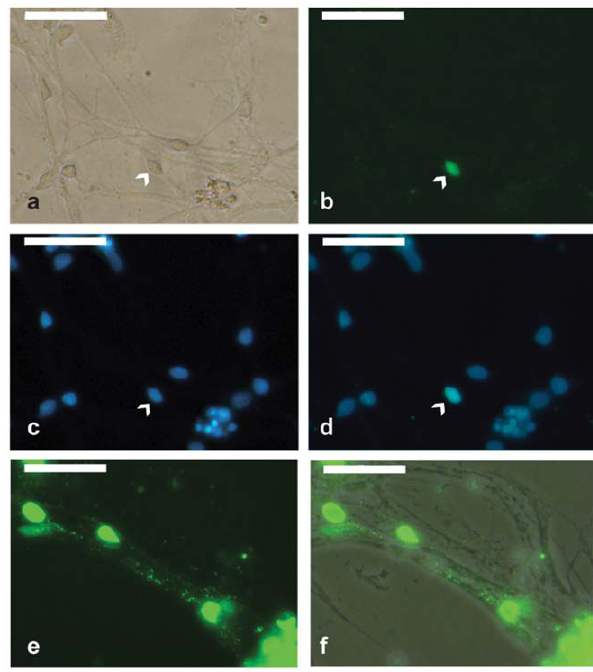
Figure 5. Mature neurons exposed to HCMV. Neuron-enriched cultures were infected with HCMV an MOI of 3. Expression of HCMV proteins was detected only in a small fraction of neurons (indicated by arrowhead) at day 3 post infection. (a) Bright-field. (b) Staining for early immediate, immediate and late HCMV antigens. (c) Nuclei counter- stained with Hoechst. (d) Overlay of HCMV antigens and bright-field. (e– f) Staining for early immediate, immediate, and late HCMV antigens shows the presence of vial proteins (green) along neural processes at day 5 post infection. (f) Overlay of viral antigens and bright-field. Scale bar is 50 m